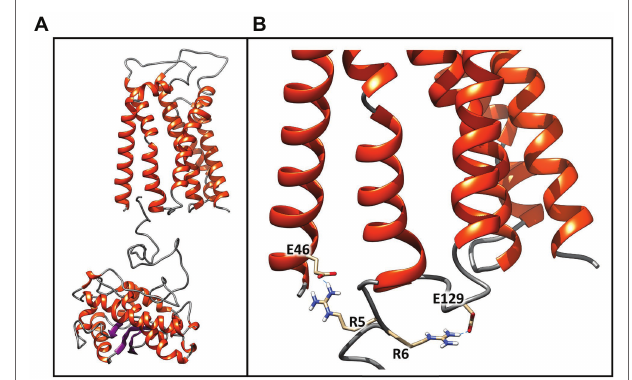
FIGURE 6 | Best molecular complex between the TaTc receptor and the SodA2.1 protein of Chroococcidiopsis sp. CCMEE 029. The β -strands are represented by violet arrows, while the α -helices and the loops are shown as orange spirals and light gray wires, respectively. The structure accounts for the 98% of the total complexes generated by the HADDOCK webserver (A) . Detail of the interactions established between the Glu46–Glu129 and the positively charged guanidinium groups of the sequential arginine residues Arg5 and Arg6 of Tat signal peptide. Glutamic acid and arginine are shown in stick representation (B) . This image was generated using the Chimera program. Molecular Docking Between ChSodA2.1